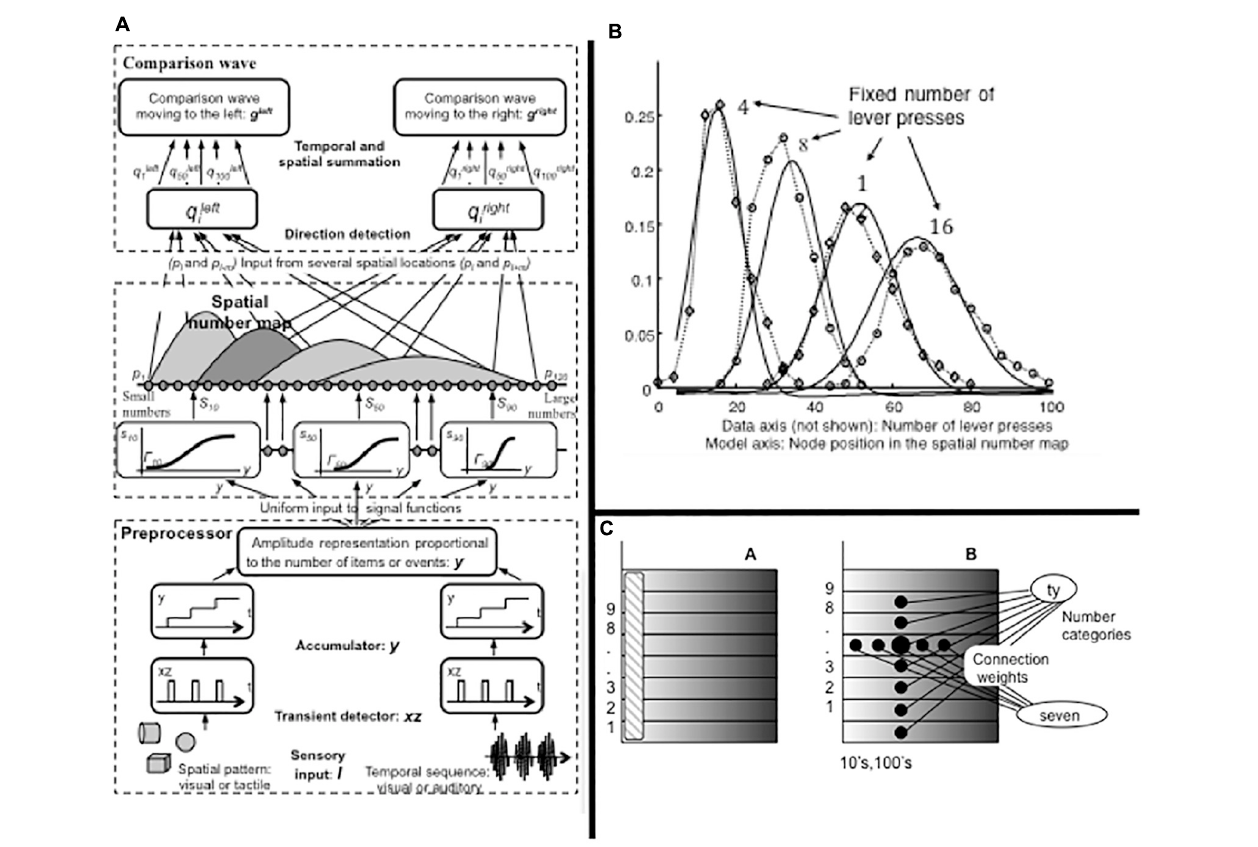
FIGURE 8 | (A) The SpaN model simulates how spatial representations of numerical quantities are generated in the parietal cortex. See text for details. (B) Behavior numerosity data and SpaN model simulation of it. The responses to increasingly large numerical inputs activate different, but contiguous, positions in the analog number map, with larger numbers generating responses further to the right on the map. The larger variance of responses to larger numbers is called the Weber Law. All these properties obtain in both the data and the model simulation. (C) The Extended SPaN, or ESpaN, model extends SpaN to be able to learn and perform place-value numbers. Interactions from the What cortical stream to the Where cortical stream accomplish this extension. In particular, previously learned phonetic categories in the What stream become associated with corresponding locations of the SpaN spatial number map in the Where stream. (CA) The striped area shows the location of the primary number map. This is extended into parallel strips all of whose cells also respond to the inputs to the primary number map. (CB) An example of where the association for seven-ty is learned in this strip map. The size of the solid circles encodes weight magnitude; the strongest association for seventy is arises at the spatial location where both the associations for categories seven and ty are present. [Reprinted with permission from Grossberg and Repin (2003)].